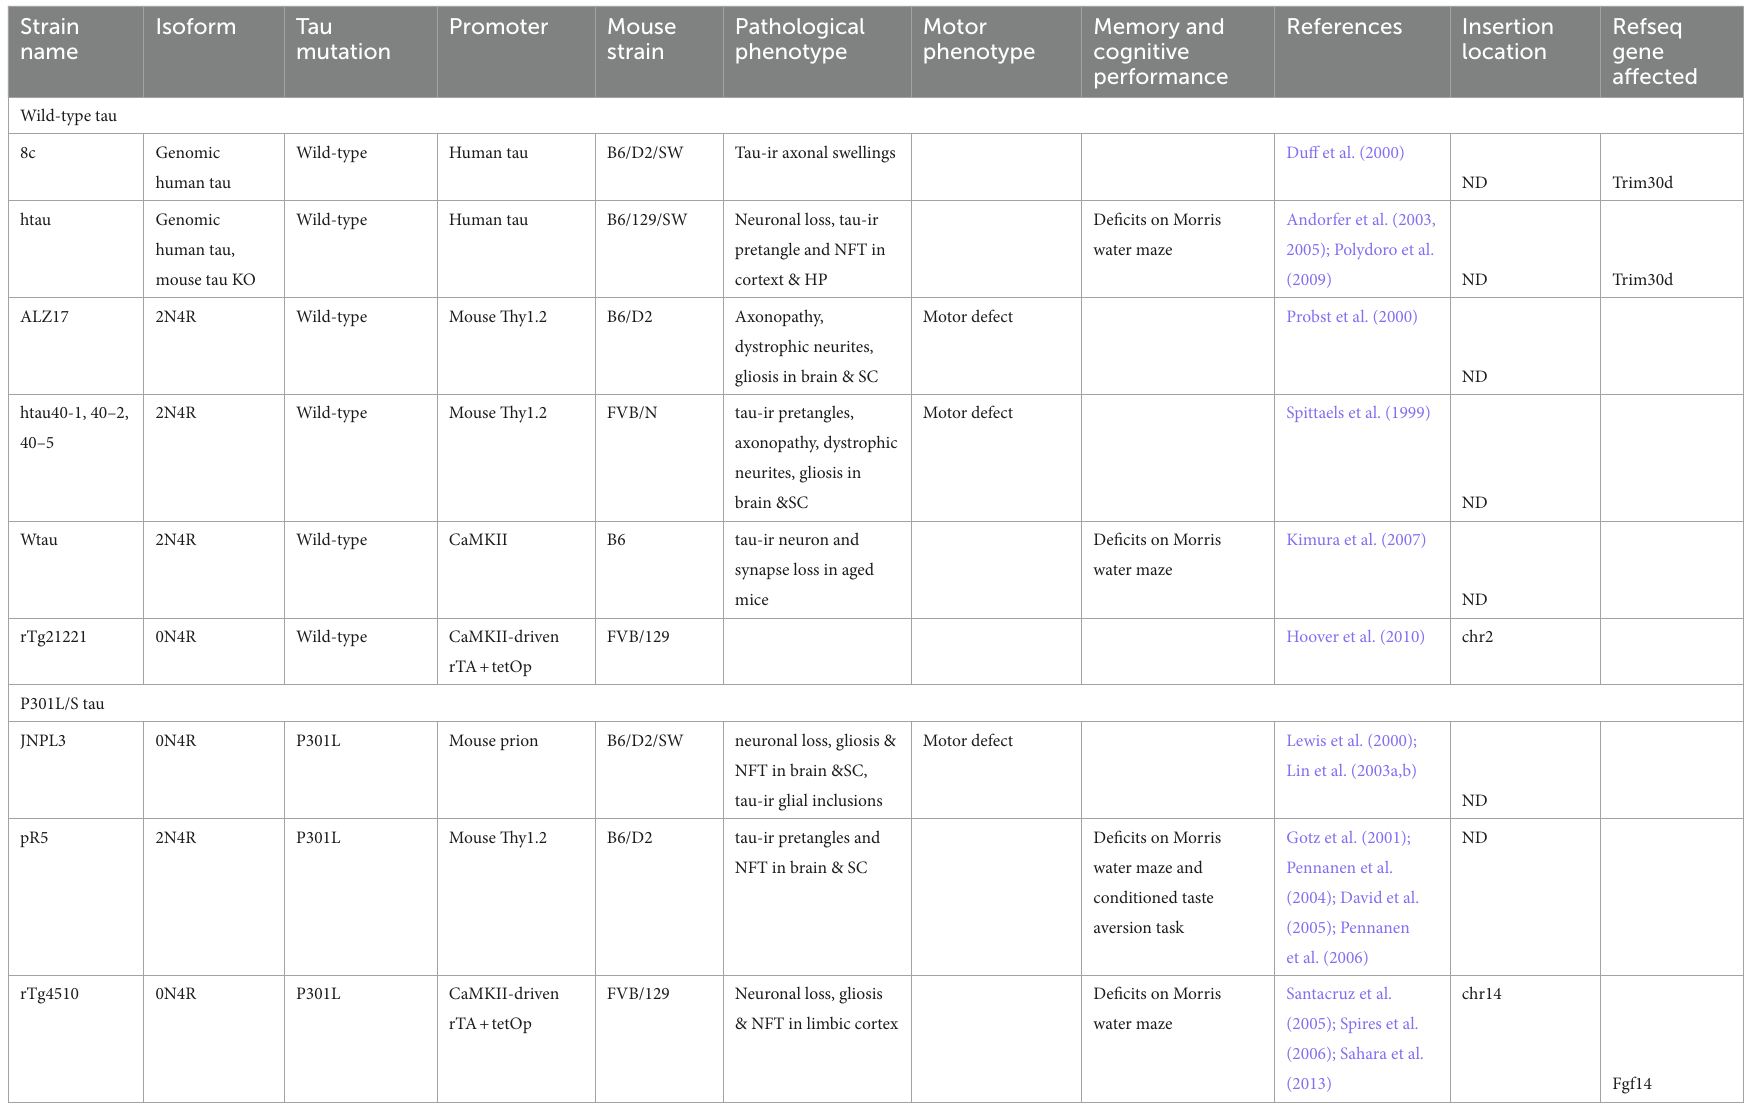
TABLE 1 List of tau transgenic